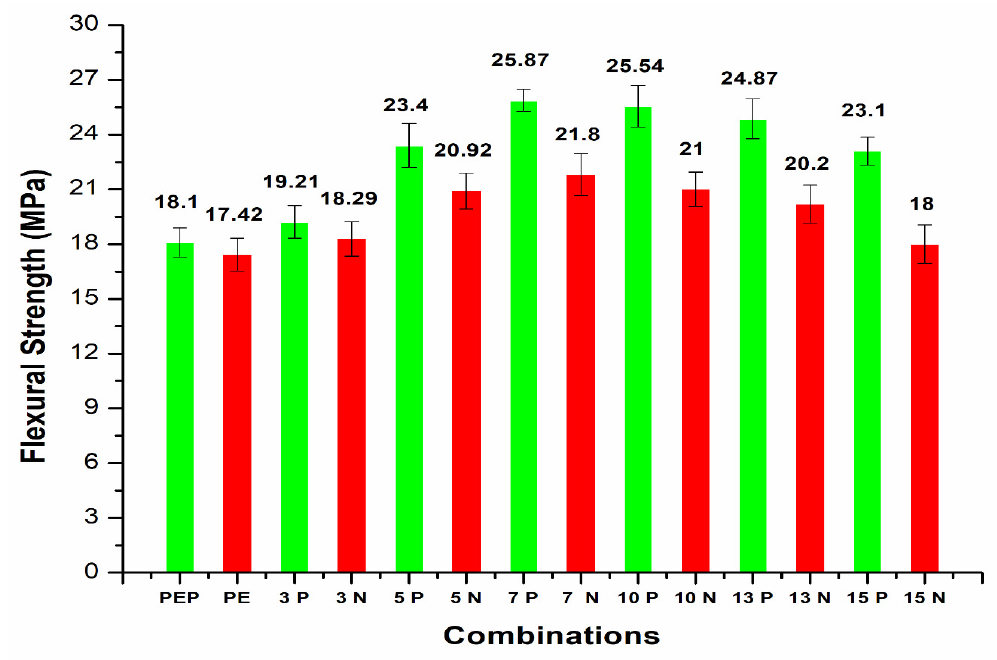
Figure 11. Flexural strength of CF/PE composites.